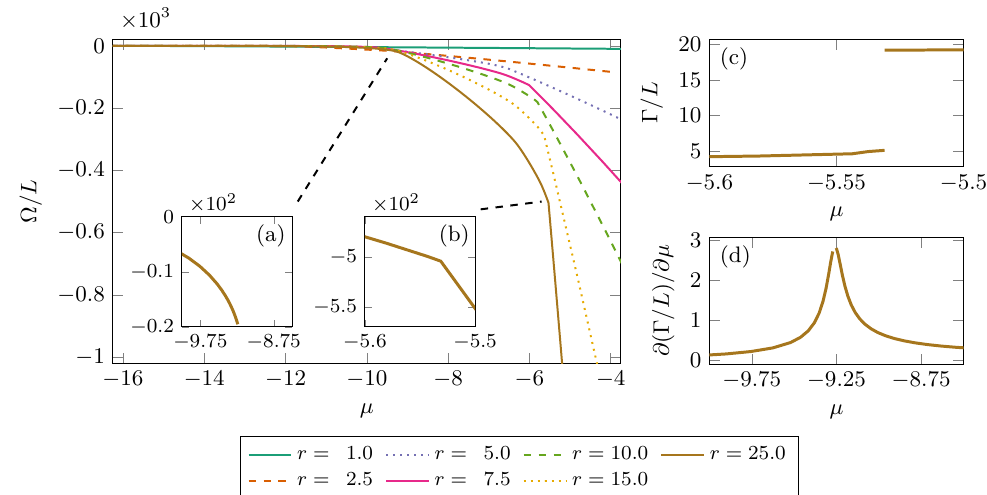
Figure 3. Dimensionless 2D grand potential, Ω / L , as a function of the dimensionless chemical potential, µ , for a Lennard-Jones fluid. Only the cDFT simulation results when χ = 1 are shown. Inset ( a ) shows the continuous phase transition which marks the onset of gas adsorption onto the wall. Panel ( d ) shows the corresponding diverging derivative of the excess adsorption. Inset ( b ) shows the discrete (first-order) capillary condensation phase transition. Panel ( c ) shows the matching jump in the dimensionless excess